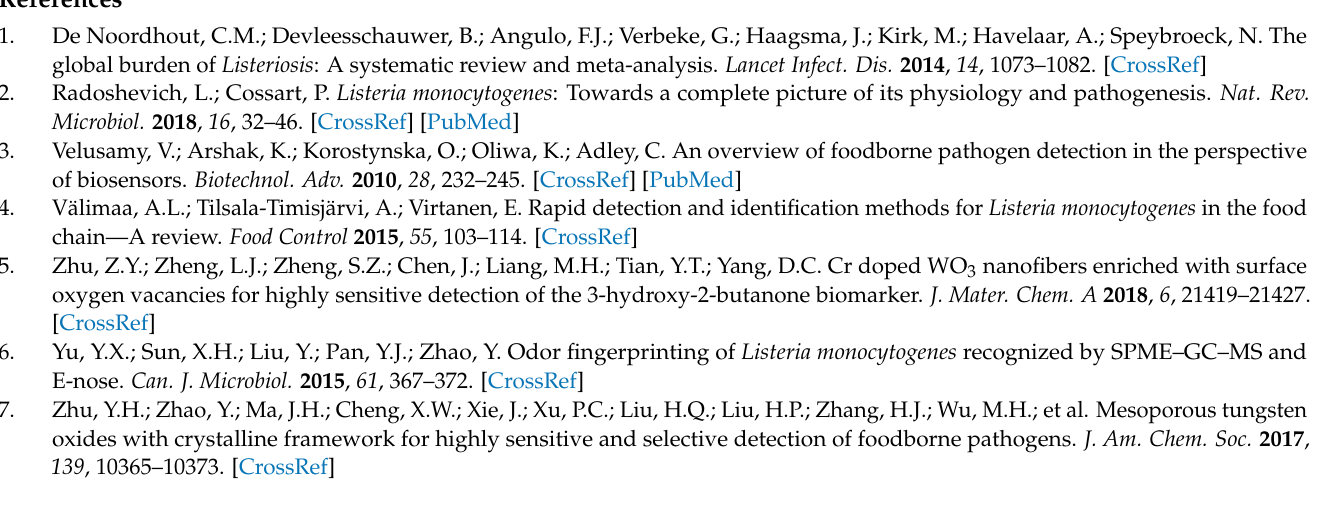
sensor measurement” sections; Figure S1: Schematic illustration for the description of MOSs sensors. (a) The panoramic view of the MEMS gas sensor test system. (b) The measuring circuit of MEMS gas sensor. (c) The test base schematic of the MEMS gas sensor. (d) The exploded views of the test base; Figure S2: The N 2 adsorption–desorption isotherms and BJH pore size distribution of (a) ZnO NS and (b) 0.5% Au/ZnO NS; Figure S3: The limit of detection of 1.0% Au/ZnO NS towards 0.5 ppm 3H-2B at 230 ◦ C; Figure S4: The long-term stability of 0.5% Au/ZnO NS, 1.0% Au/ZnO NS, 1.5% Au/ZnO NS, and 2.0% Au/ZnO NS towards 10 ppm 3H-2B at 230 ◦ C; Table S1: The comparison of the gas sensing properties of 1.0% Au/ZnO NS sensors with other MOS-based 3H-2B sensors in